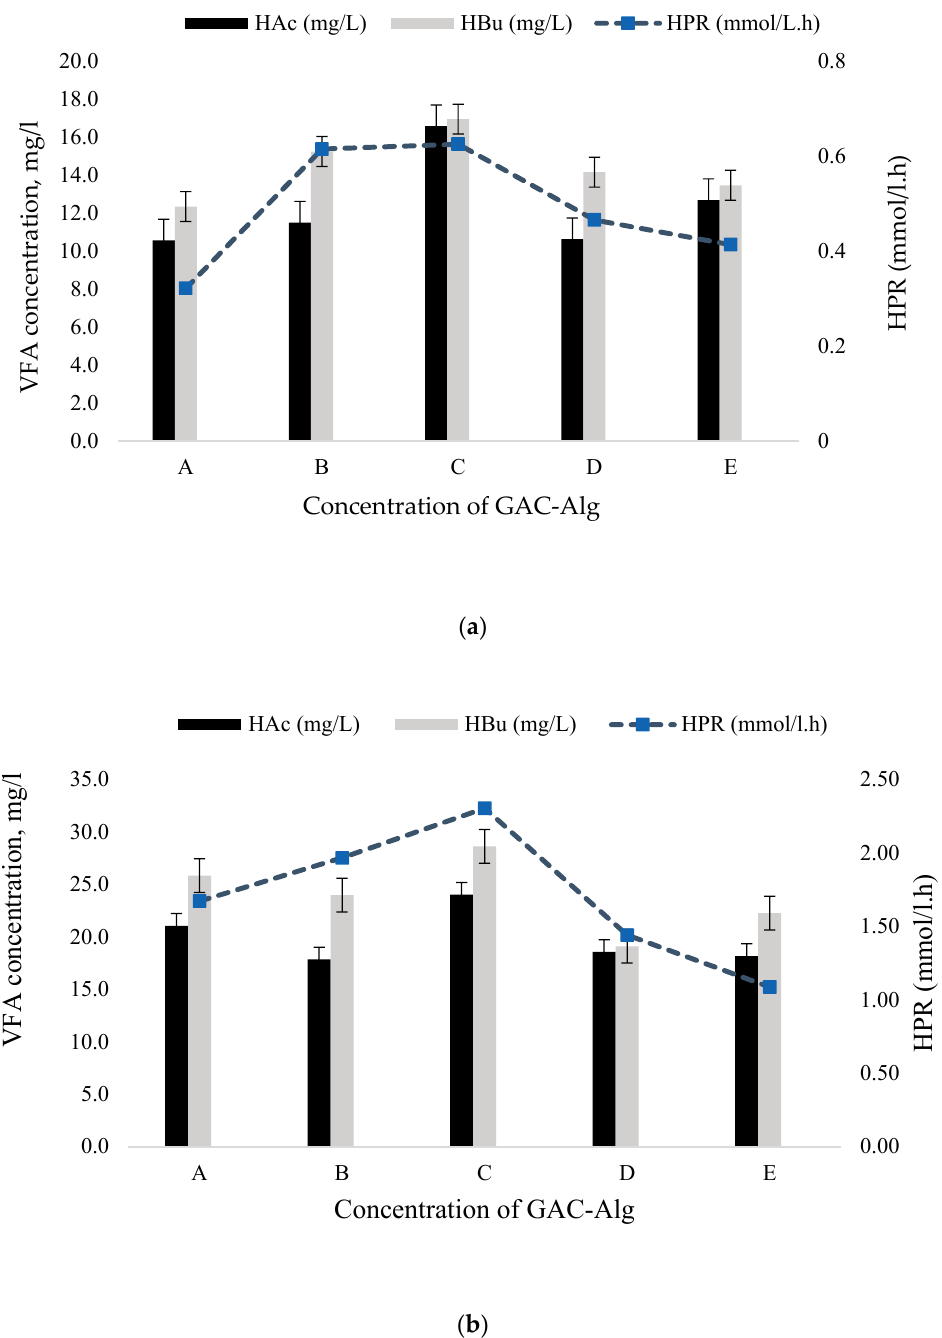
Figure 8. Hydrogen production rate (mmol/l.h) and VFA concentration (HAc-acetate acid and HBu-butyrate acid) in batch fermentation of ( a ) GAC-Alg and ( b ) GAC-lgC beads.